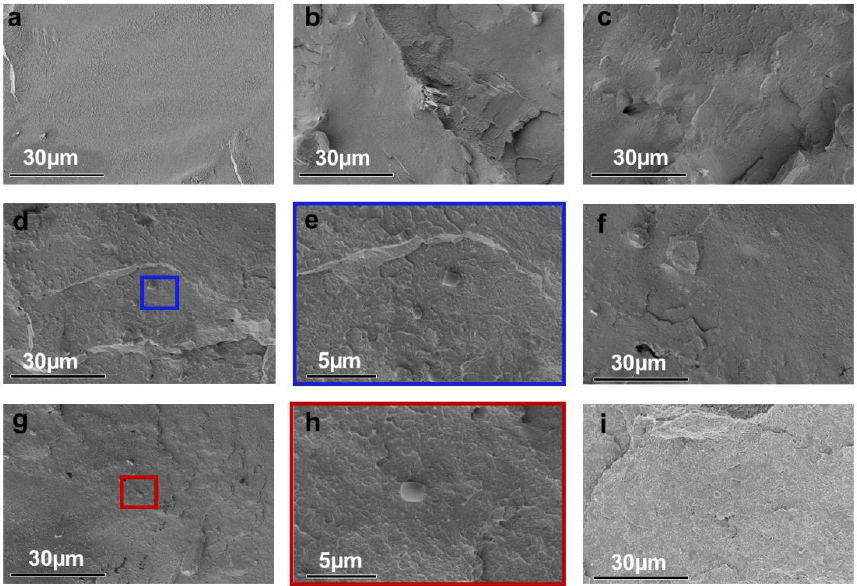
Figure 3. SEM images of fracture surface of ( a ) PS, ( b ) PA, ( c ) PAC1, ( d , e ) PAC2, ( f ) PAC4, ( g , h ) PAC7, and ( i ) PAC10 after